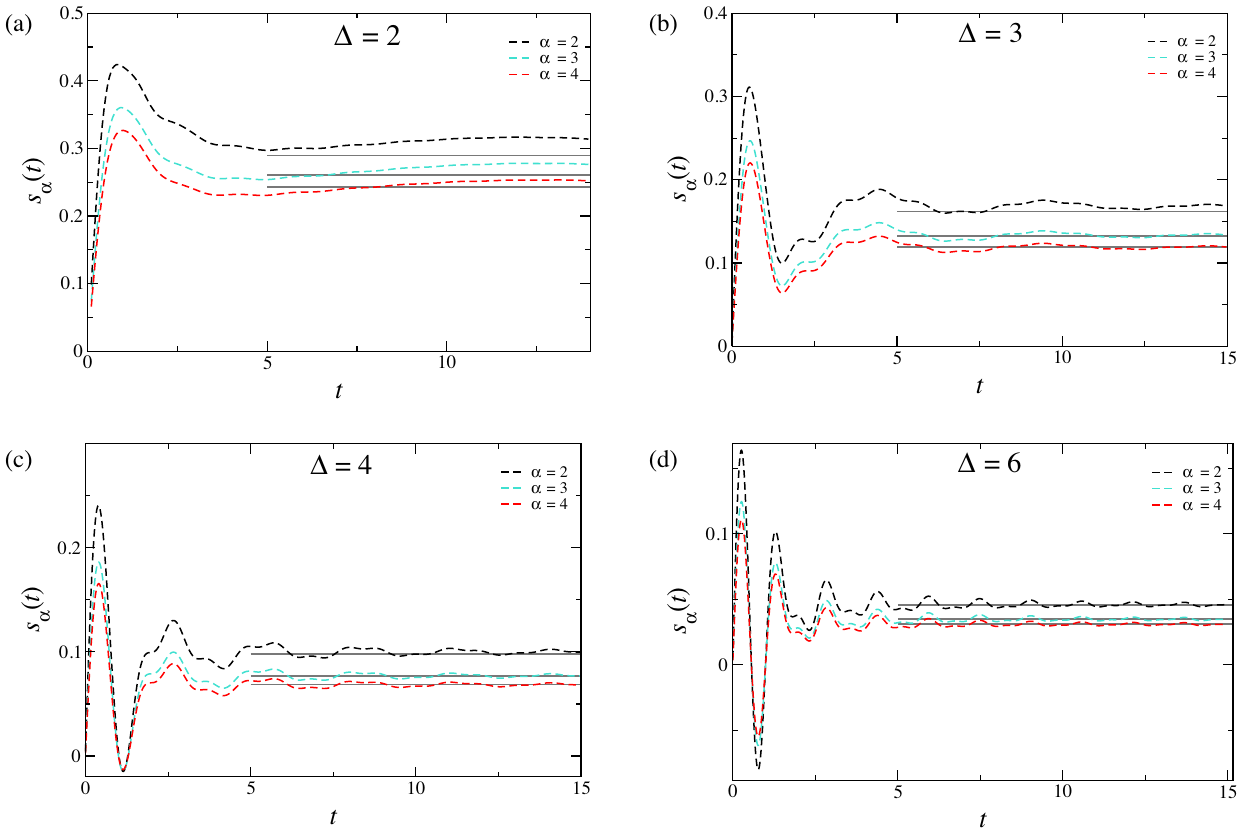
FIG. 4. Numerical results for instantaneous R´enyi slope s α ð t Þ after the quench from the N´eel state (80). The dashed lines represent the numerical data, with different colors distinguishing between different values of α , while horizontal solid lines denote the analytical predictions for s α . Each panel corresponds to a different value of the anisotropy parameter: (a) Δ ¼ 2 , (b) Δ ¼ 3 , (c) Δ ¼ 4 , and (d) Δ ¼ 6 .